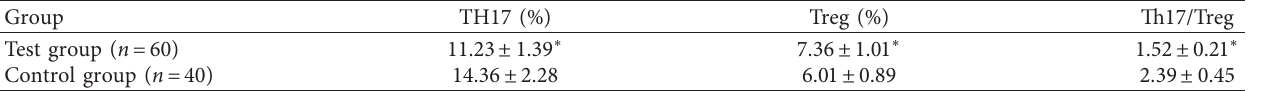
Table 2: The proportion of TH17 cells, Treg cells, and their ratio between the test and control groups.